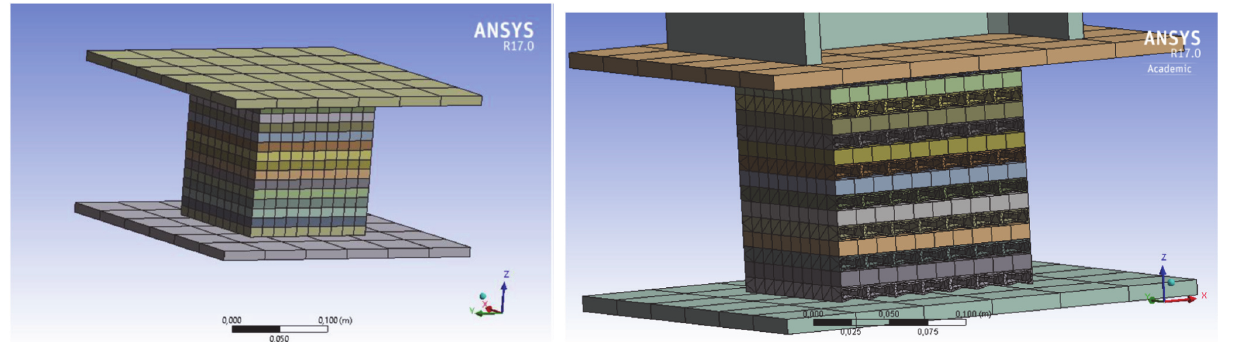
Figure 6: Mesh of the conventional and the auxetic base isolation.